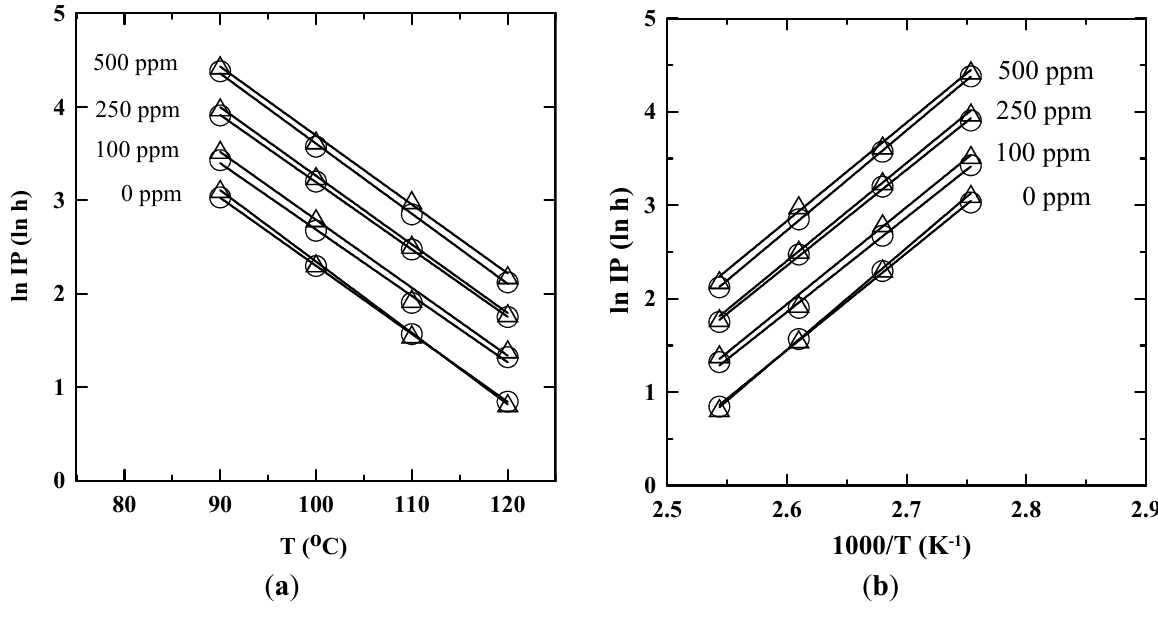
Figure 4. The relationship between ln IP and T for the SNME and FFA-based biodiesel blend stabilized with various C of PDA. ○ and Δ : EN 14,112 and EN 15,751, respectively. 0 ( a ) Linear relationship between ln IP and T (°C); ( b ) linear relationship between ln IP and 1/T (K − 1 ).